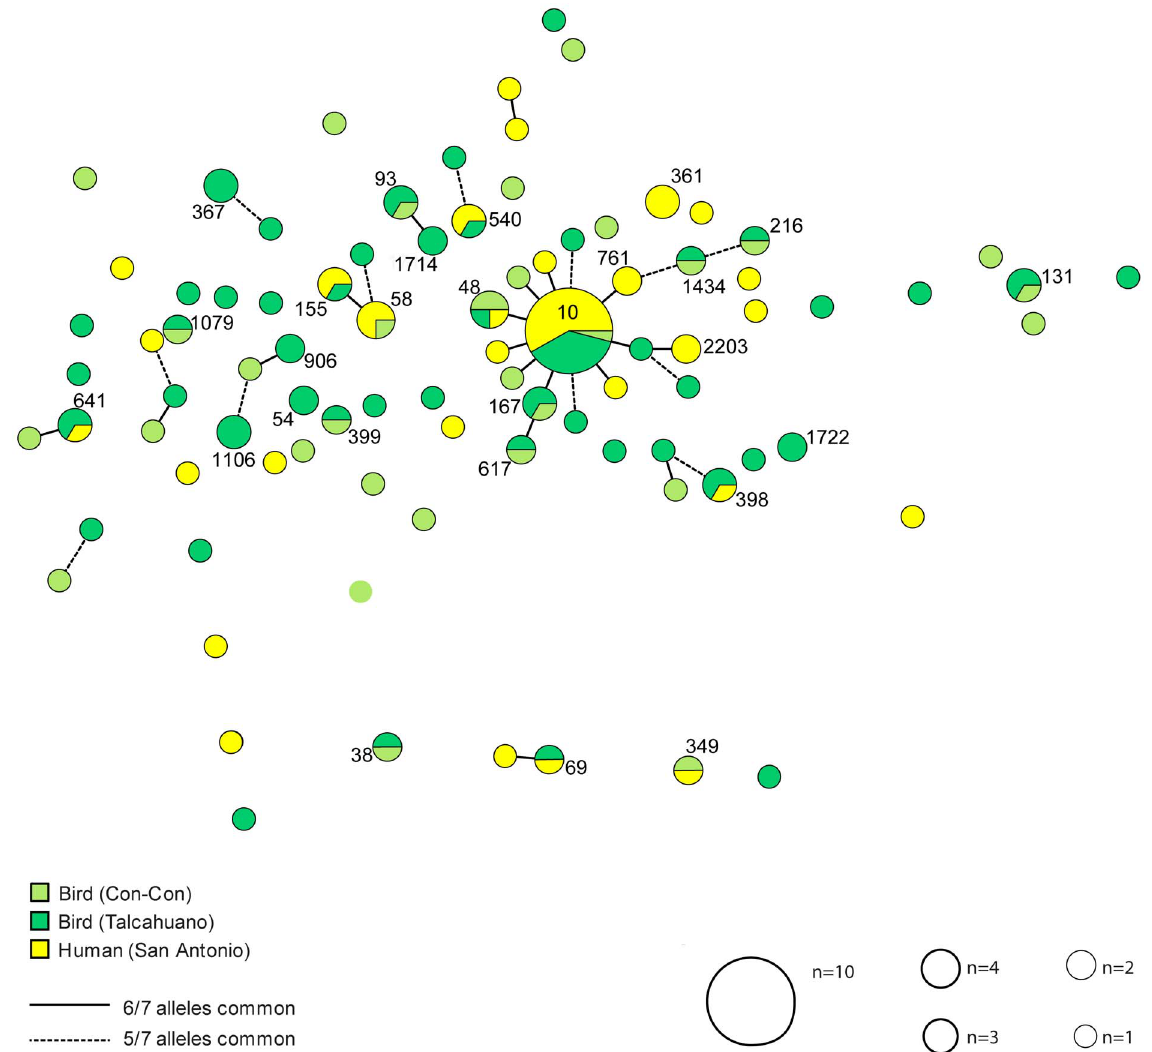
Figure 2. Minimal spanning tree calculated from the allelic differences between the isolates. The tree shows the relationship between the genetic analysis and the geographical source of the isolates.